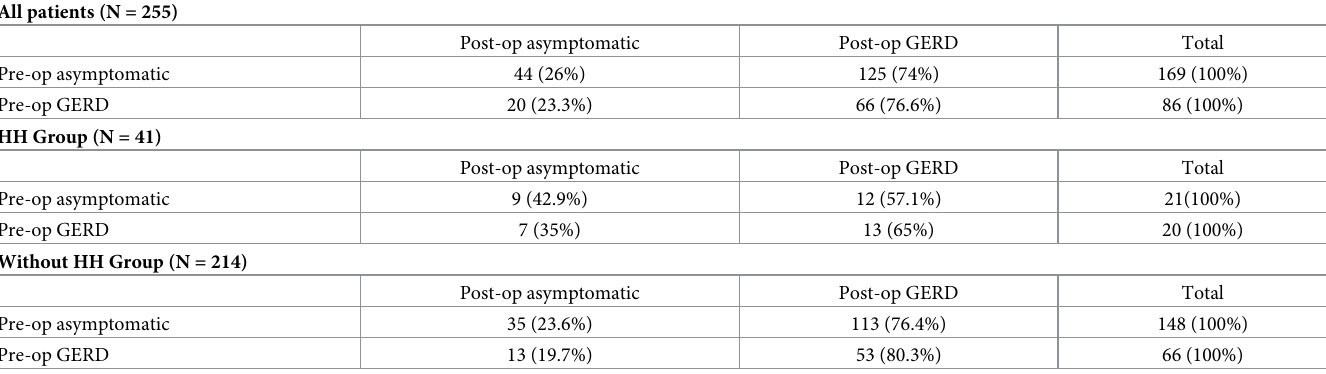
Table 2. Prevalence of GERD pre- and post-sleeve gastrectomy. All patients (N = 255)